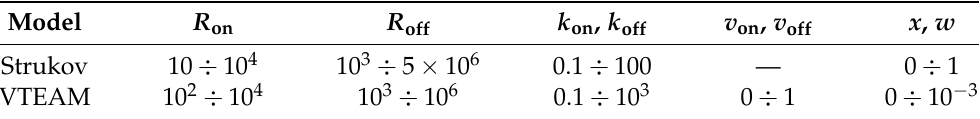
Table 2. Box constrains for the real-valued parameters of vector x